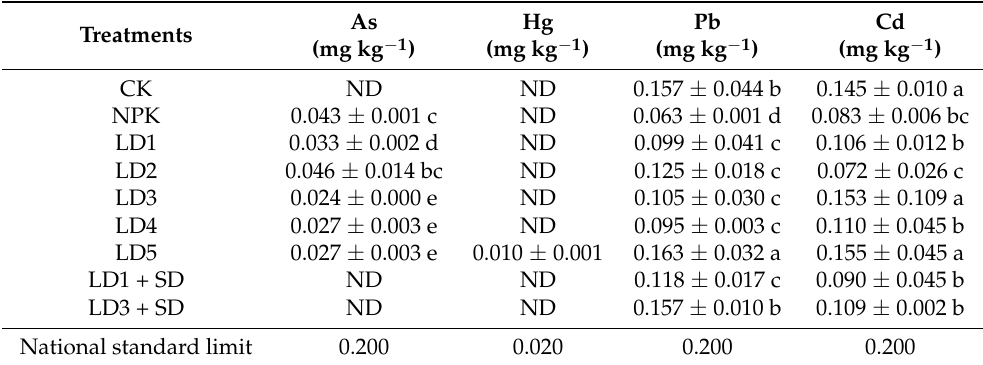
Table 3. The arsenic (As), mercury (Hg), lead (Pb), and cadmium (Cd) content in rice grains under different treatments,